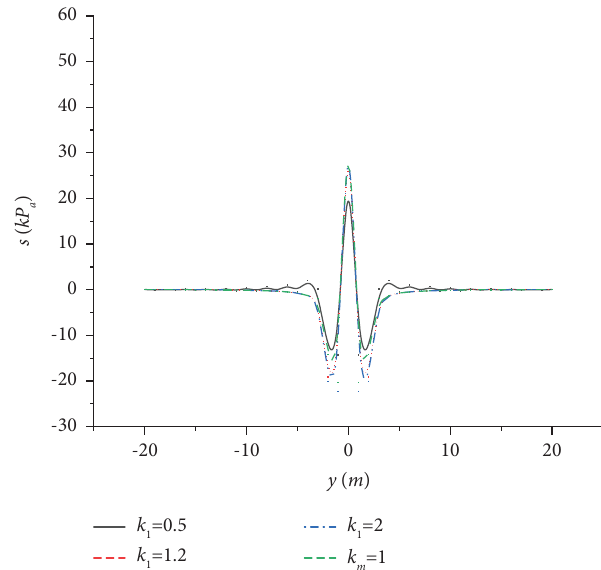
Figure 10: Contact stress curves in y- direction due to E